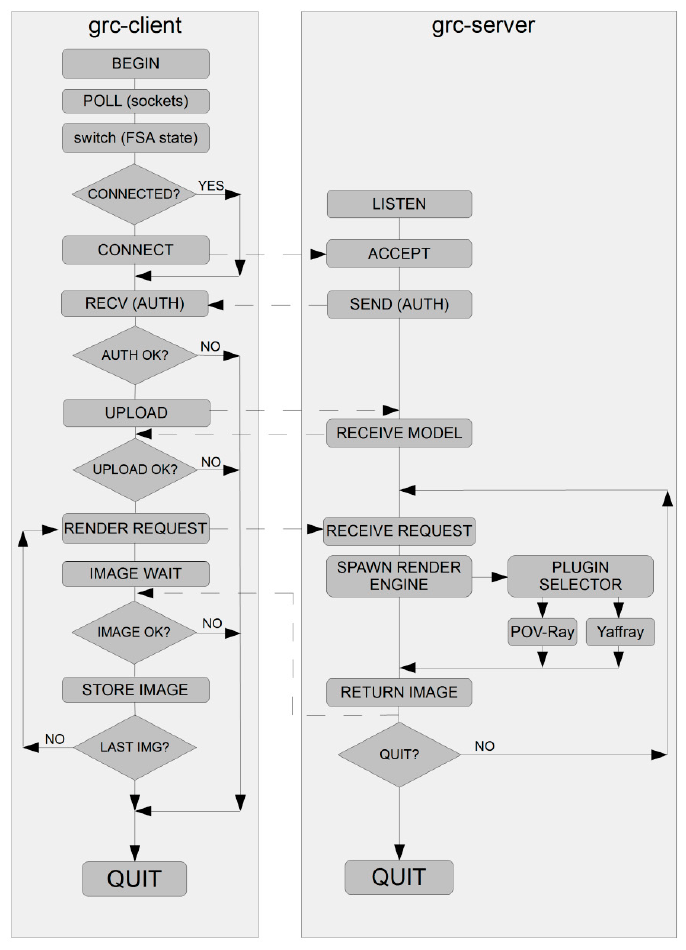
Figure 2. Algorithm flowchart for GRC-client and